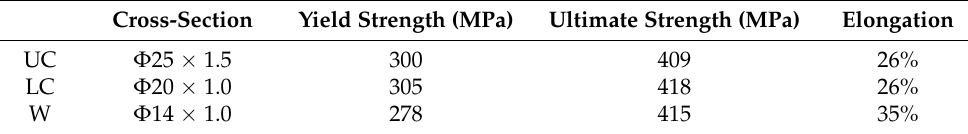
Figure 2. Geometry and number of the roof truss (unit: m). Table 1. Geometric dimensions and material properties of members. Table 1. Geometric dimensions and material properties of